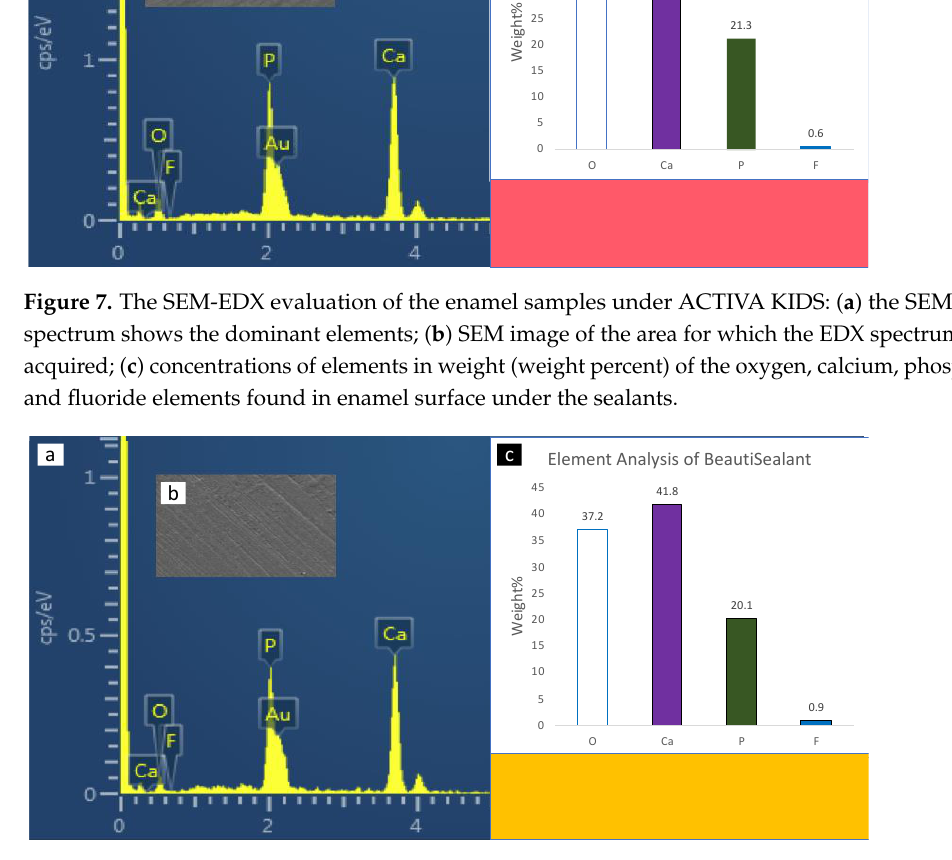
Figure 8. The SEM-EDX evaluation of the enamel samples under BeautiSealant: ( a ) the SEM-EDX spectrum shows the dominant elements; ( b ) SEM image of the area for which the EDX spectrum was acquired; ( c ) concentrations of elements in weight (weight percent) of the oxygen, calcium, phosphate and fluoride elements found in enamel surface under the sealants. Figure 9 represents the polarized light photomicrographs of longitudinal sections of the samples after 7 days in the pH-cycling model. The dark bands on the surfaces repre- sent the demineralized areas of the enamel. The negative control group and non-bioactive sealant showed wide dark bands that represent the demineralization areas. Av showed a wider demineralization band in comparison to the other bioactive groups. However, the demineralization band was narrower than both control groups. Bc showed a narrow de- mineralization band whereas Bu showed almost no demineralization on the surface of enamel. Figure 9. Photomicrographs of a longitudinal section of enamel under the sealed areas taken with polarized light. Dark bands at the surface (arrows) represent the demineralized enamel. (B) Blank and (Si) Seal-it sealant represent images under the negative control and non-bioactive sealant, re- spectively. (Av) ACTIVA KIDS Bioactive—restorative , (Bc) BioCoat ® sealant and (Bu) Beau- tiSealant show images of enamel under the bioactive sealants.